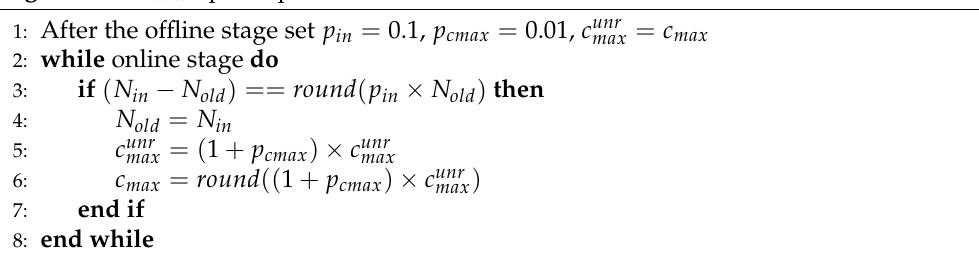
Algorithm 1 c max update